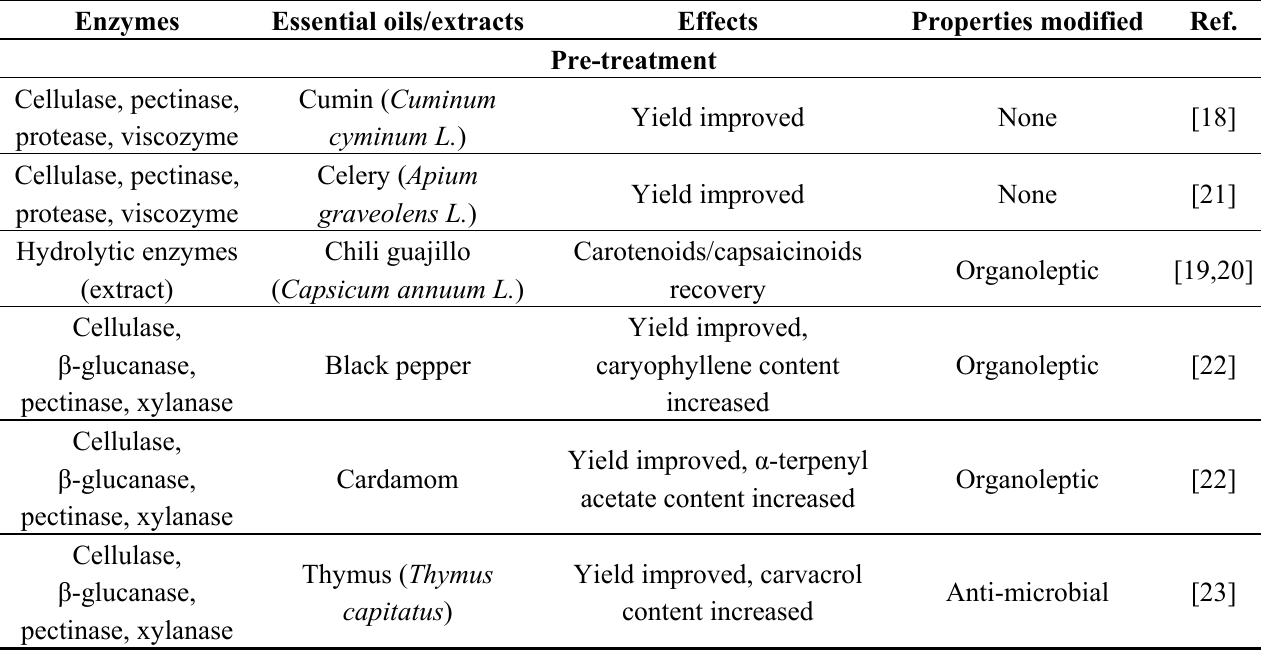
Table 1. Summary of the uses of enzymes for the modification of essential oils presented in this